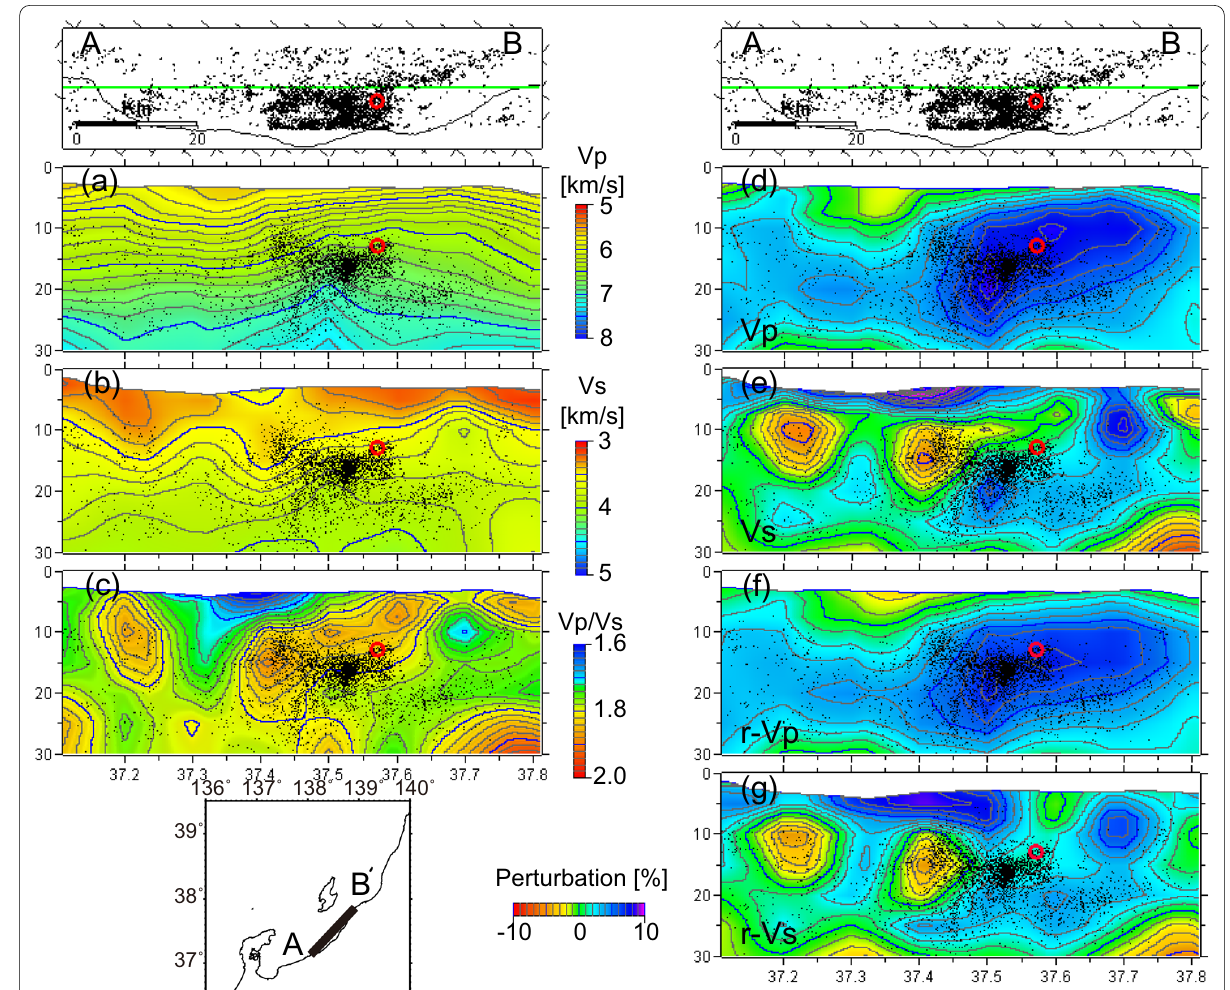
Fig. 18 Seismic velocity structure and restored resolution test around the 2007 offshore Chuetsu earthquake. Red circle denotes the hypocenter of the 2007 offshore Chuetsu earthquake determined with 3D